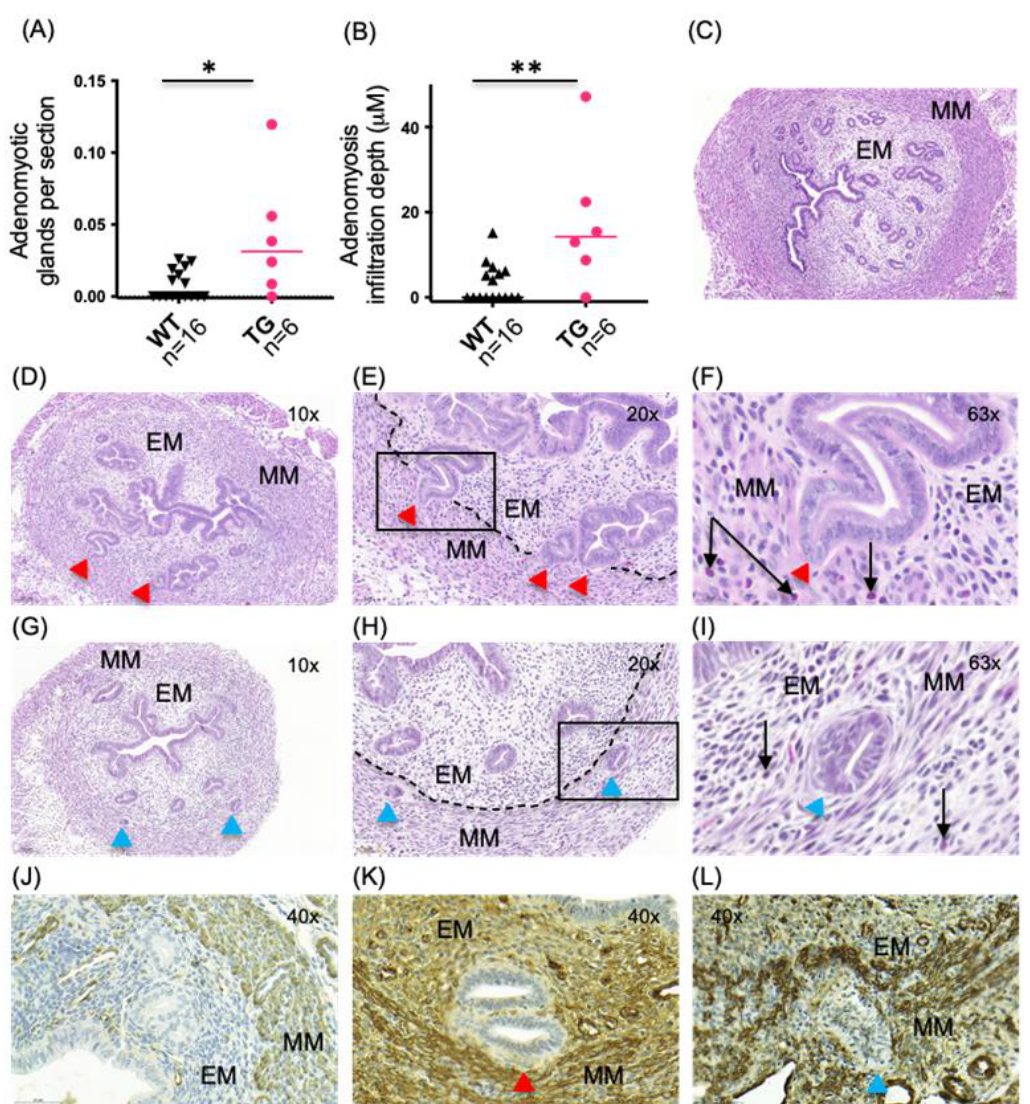
Figure 3. Adenomyotic changes are increased in HSD17B1TG females at the age of 5.5 months. ( A ) Significantly increased numbers of adenomyotic glands per analyzed sections were observed in HSD17B1TG mice compared to WT mice. ( B ) The infiltration depth was also significantly higher in HSD17B1TG mice compared to WT mice. ( C ) A cross-section of WT uterus without adenomyotic changes. ( D ) A cross-section of HSD17B1TG uterus with infiltrating glands. ( E ) A higher magnification of ( D ) with the endometrial and myometrial border highlighted with dashed line. ( F ) A higher magnification of ( E ), showing an infiltrating gland and eosinophils. ( G ) Few fully infiltrated glands were also observed in the HSD17B1TG mice. ( H ) A higher magnification of the section shown in Figure ( G ), with the endometrial–myometrial border highlighted with dashed line. ( I ) Eosinophils in the HSD17B1TG uterus. ( J ) Endometrial stroma of the WT uterus was negative in immunohistochemistry for smooth muscle actin (SMA). ( K ) SMA staining shows a partially infiltrated gland in HSD17B1TG mice. ( L ) SMA-staining showing fully infiltrated HSD17B1TG gland. The SMA-positive endometrial stroma is apparent in ( K , L ). * p < 0.05, ** p < 0.01, EM = endometrium, MM = myometrium, red arrowheads = partially infiltrated glands, blue arrowheads = fully infiltrated glands, black arrows = eosinophils, black squares = the areas shown in higher magnification, triangle = WT, circle =